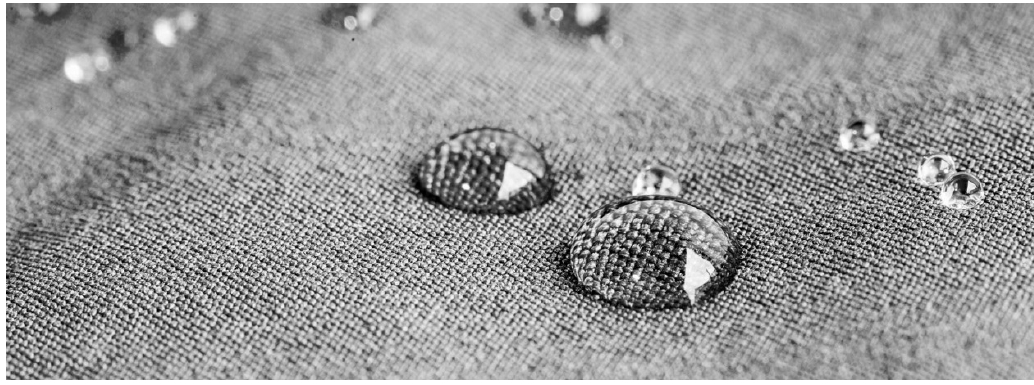
Figure 4. Water repellent interlinings.